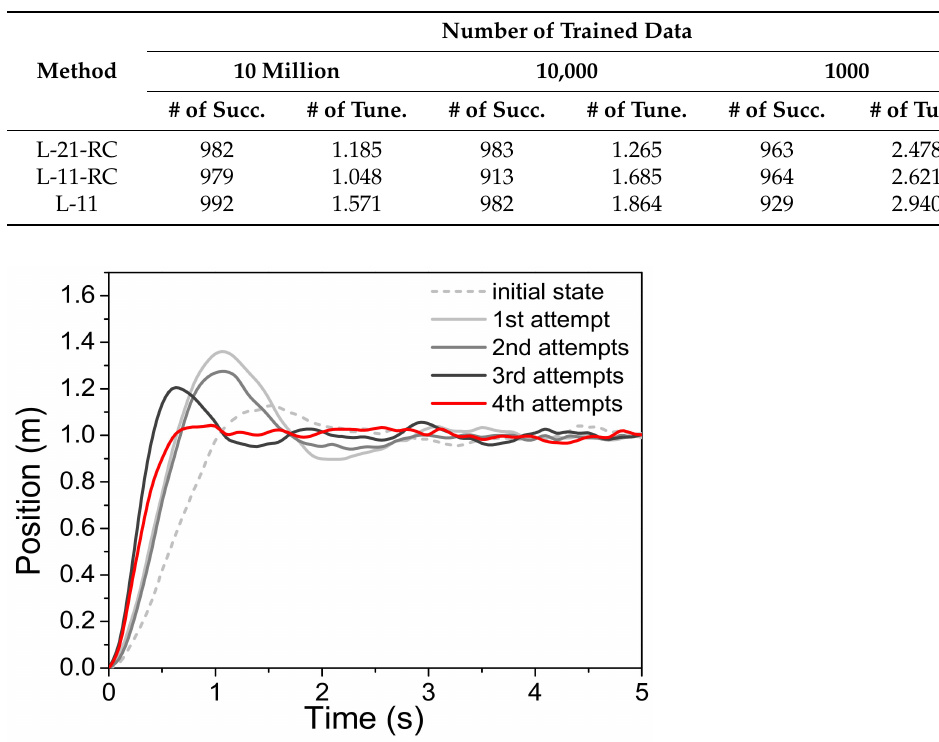
Table 4. Number of successful tuning attempts and average number of tuning attempts to success using LSTM networks by reducing the number of learning data. “# of Succ.” means number of successful attempts, and “# of Tune.” means average number of tuning attempts to success.